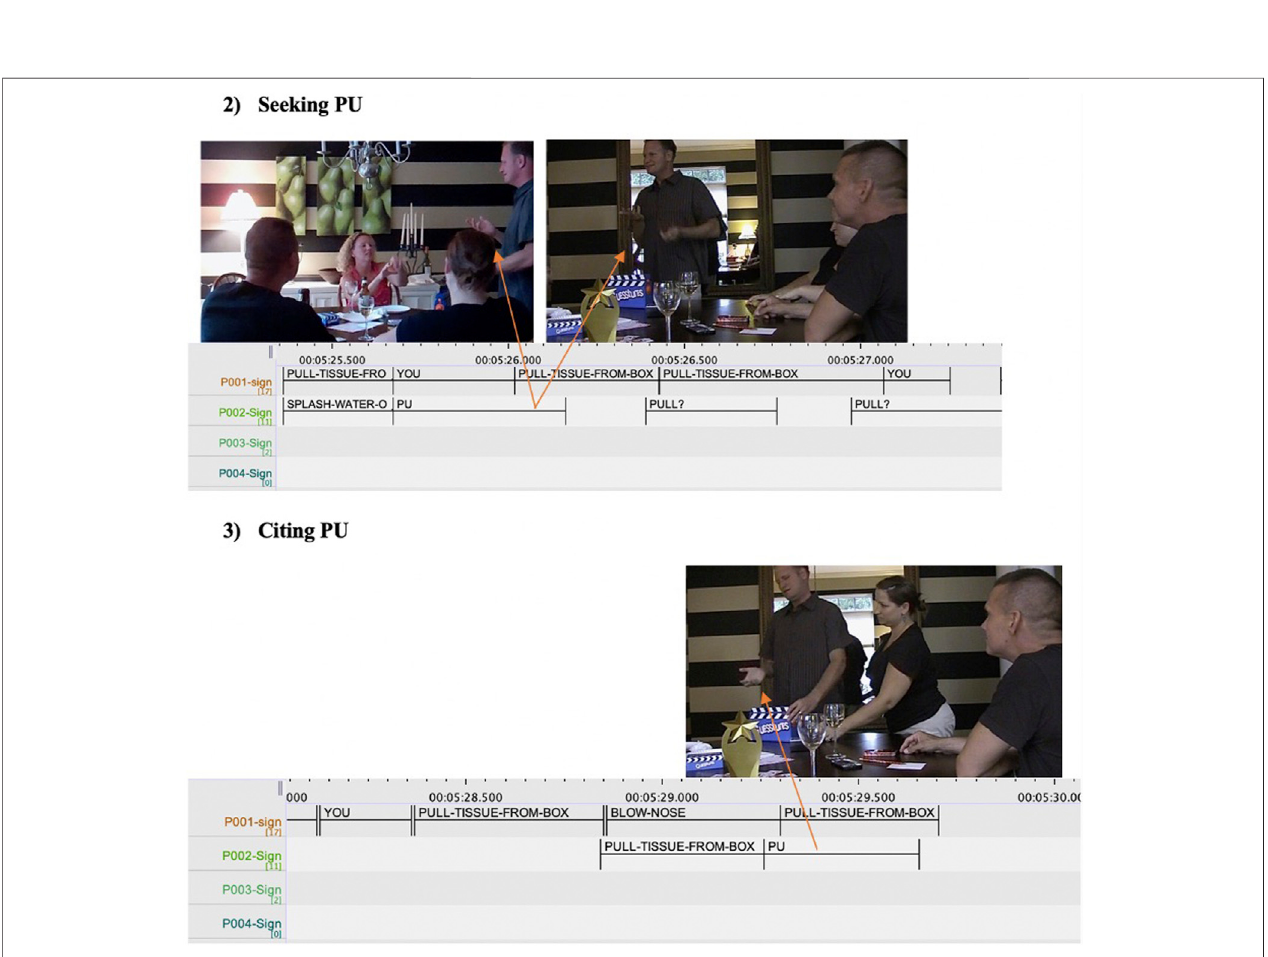
FIGURE 8 | Seeking and citing PU in